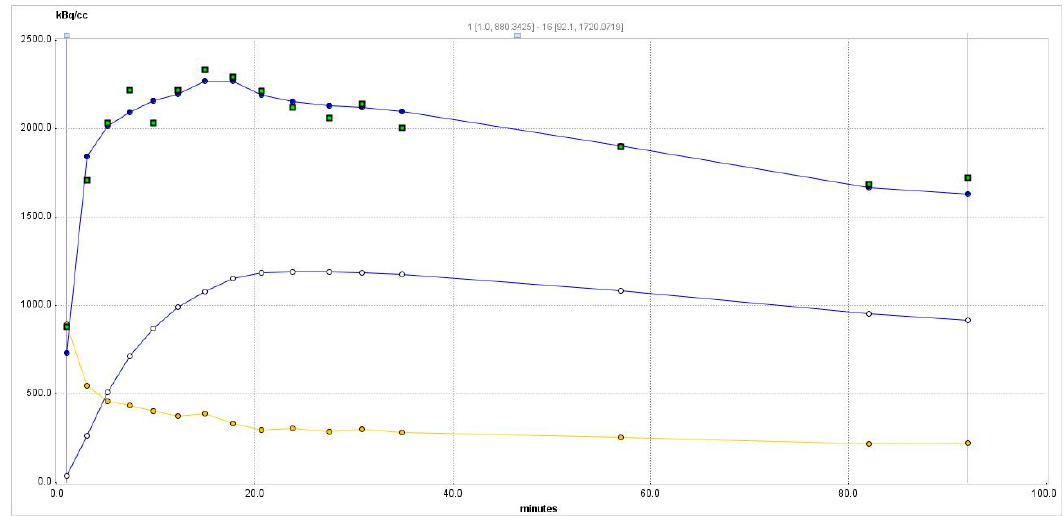
Figure 3. Time-activity curve of the PET radiotracer in the hyperplastic thyroid. Squares—experimental data point from the right thyroid. The blue curve passing among these points is a two-tissue compartment model curve from Equation (1). Yellow circles show whole-blood data derived from the image; the yellow curve is the whole-blood curve. Empty circles show the specific binding concentration C 2 .